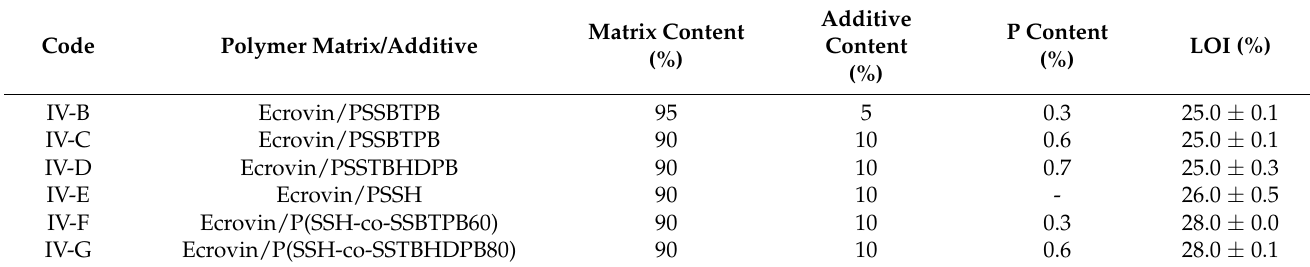
Table 5. LOI measurements of Ecrovin ® LV 340 eco blends.